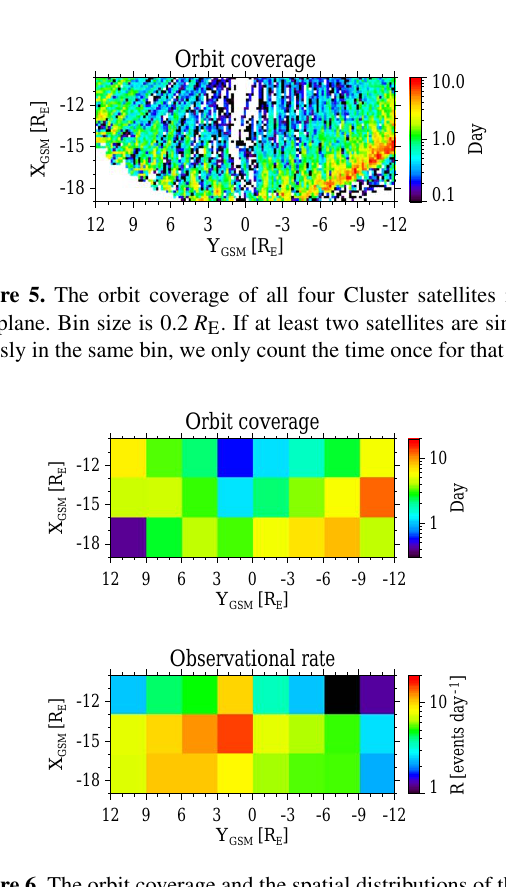
Figure 6. The orbit coverage and the spatial distributions of the oc- currence rate of the DFs observed by all four Cluster satellites in the XY plane. Bin is 3 × 3 R E . If at least two satellites are simulta- neously in the same bin, we only count the time once for that bin; if at least two DFs, which belong to a same DF event, are observed by different satellites and located in the same bin, we only count the DF once for that bin.